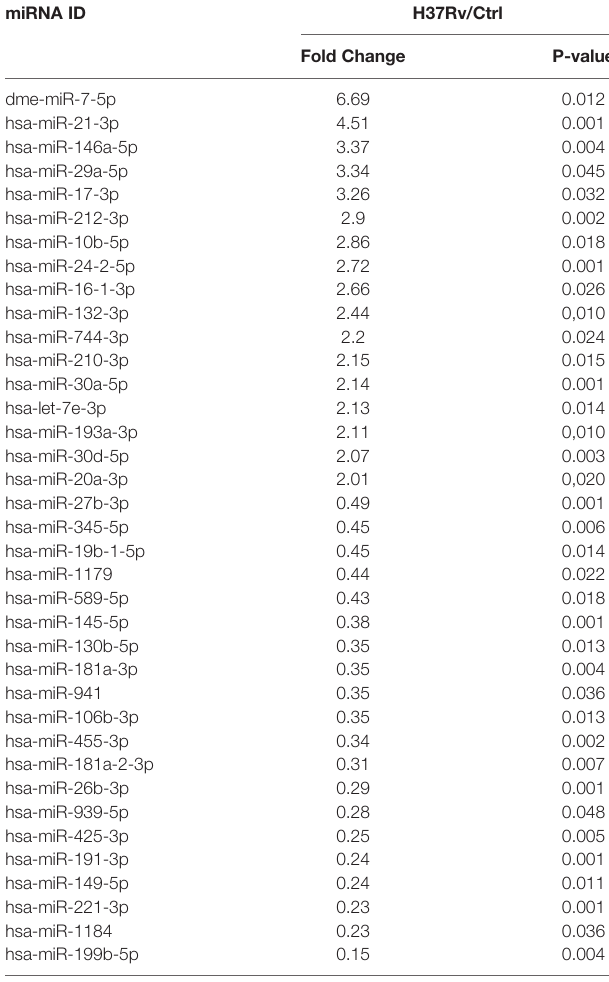
TABLE 2 | H37Rv mediated miRNA